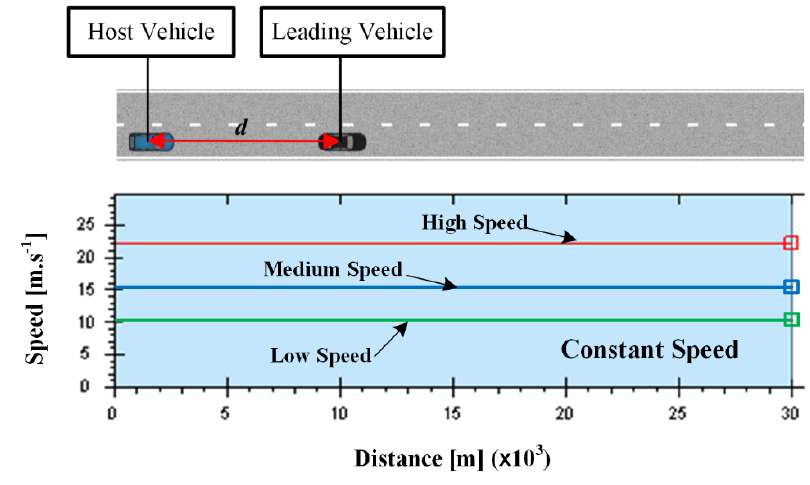
Figure 3. Driving scene for constant speed scenario.